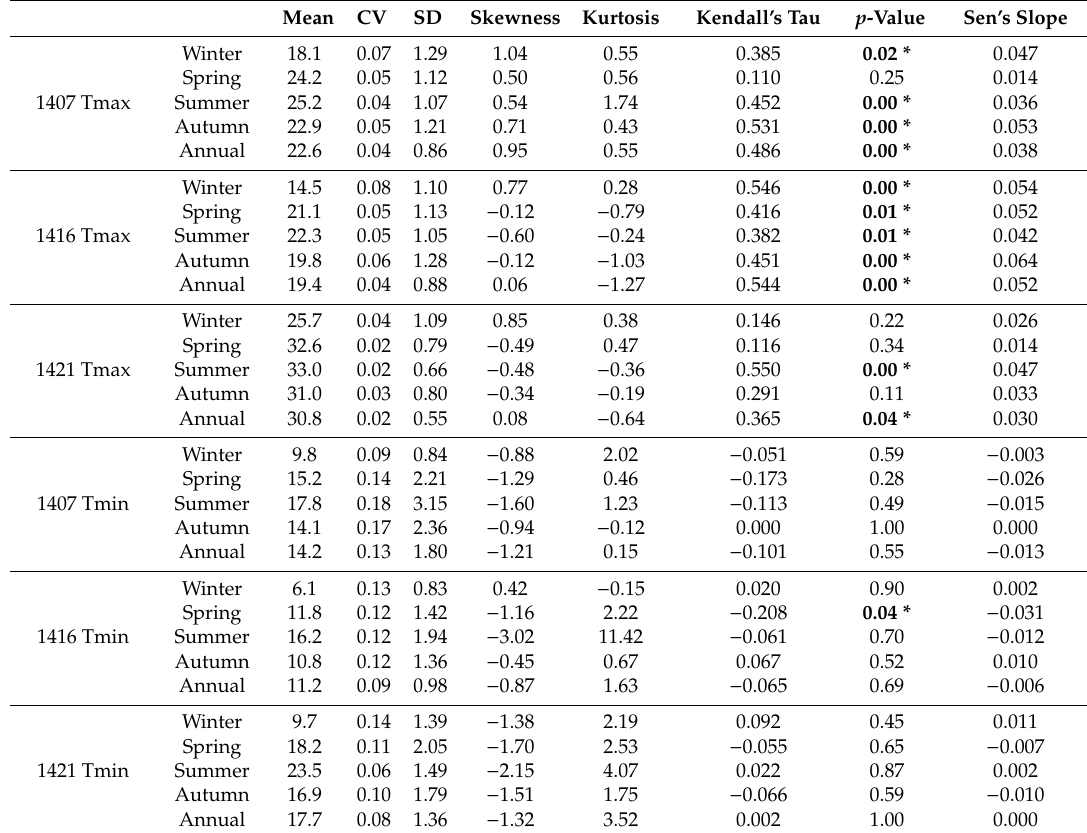
Table 2. Statistical analysis for the maximum (Tmax) and minimum temperature (Tmin) for di ff erent Standard